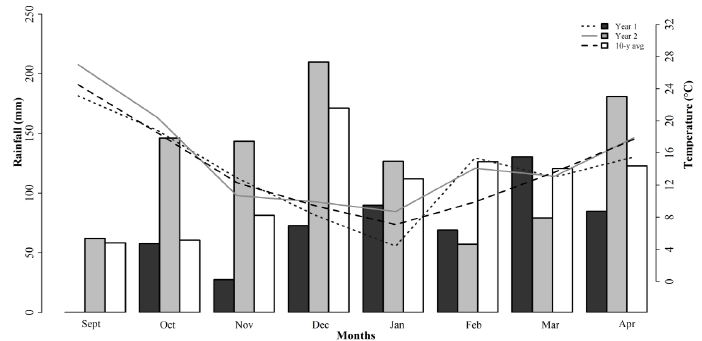
Figure 1. Monthly weather data during studies 1, 2, and 3 and 10-year average at Shorter, AL. Bars and lines indicate cumulative monthly rainfall and average temperatures,